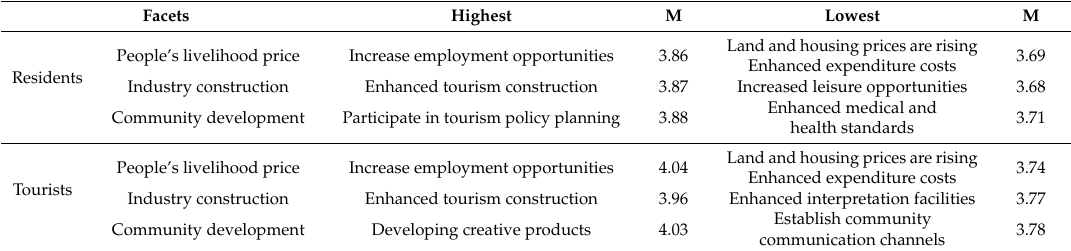
Table 5. The perceptions of residents and tourists of the current economic development. Facets Highest M Lowest